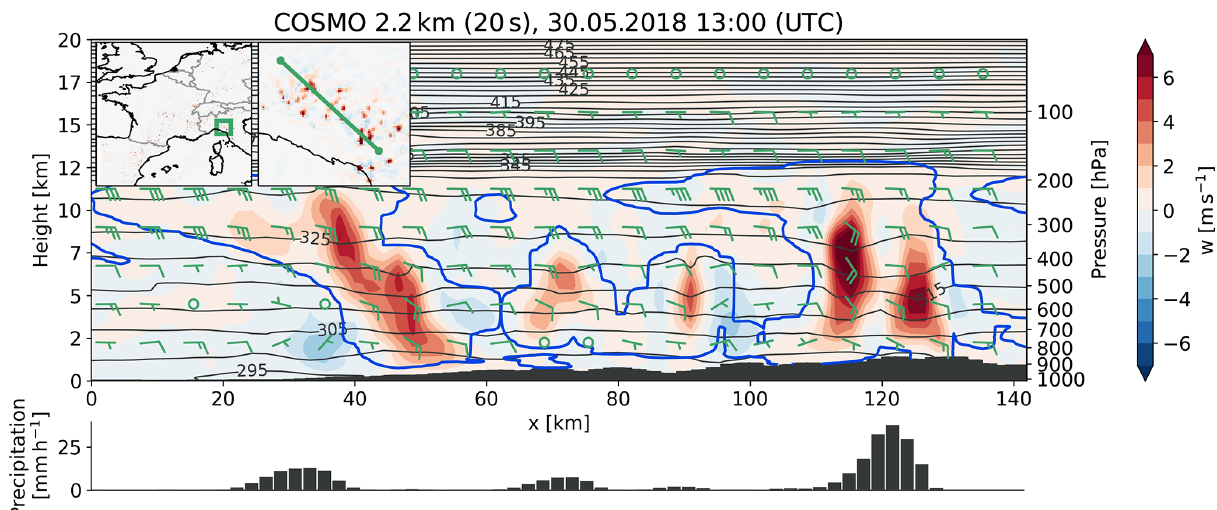
Figure 7. Cross section of convective cells over Northern Italy produced by COSMO 2.2km. The shading represents the vertical wind speed, the green barbs the overall wind direction and velocity, and the blue contour the clouds (cloud water + cloud ice content > 0 . 01gkg − 1 ). The black contours represent potential temperature, and the bar chart at the bottom shows the location and intensity of accumulated precipitation over the last